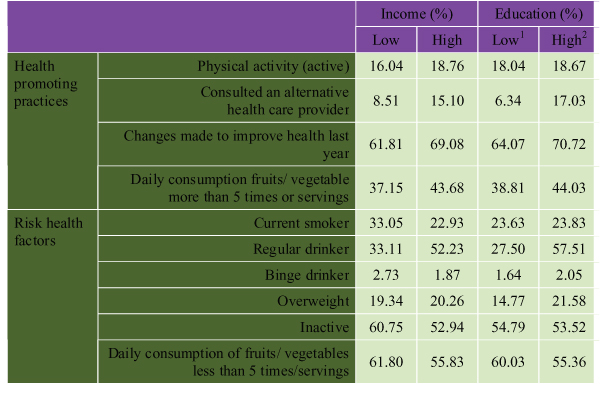
Income/Education and Health Practices (not age-adjusted). Source: Statistics Canada, CCHS, 2000–2001.1Low education: less than secondary school graduate.2High education: at least secondary school graduate.